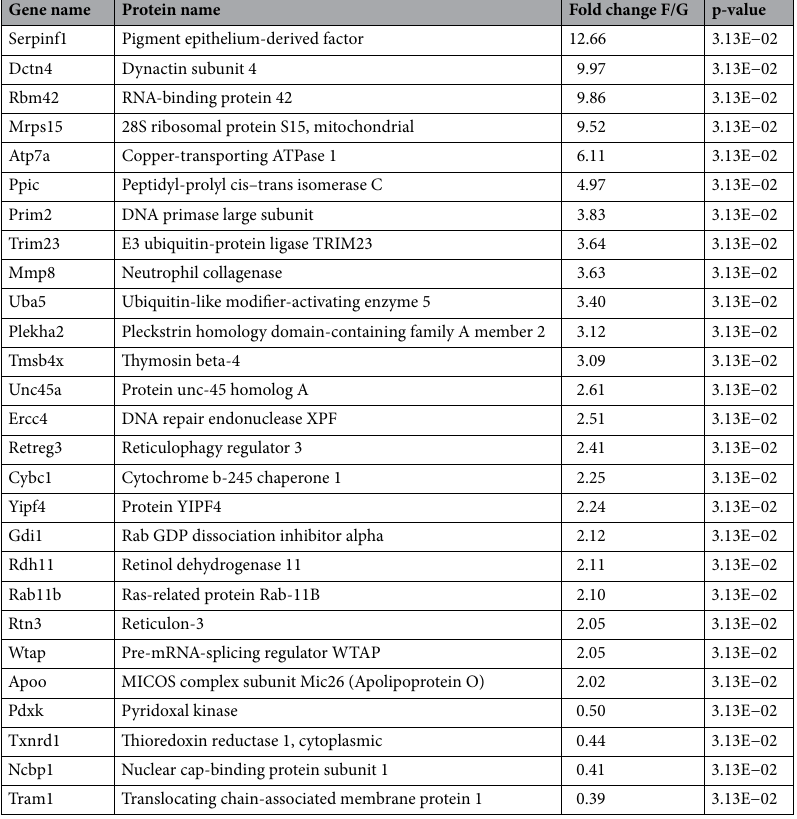
Table 2. Effect of collagen morphology on the protein expression profile of macrophages. 23 proteins were expressed at levels more than twofold higher in macrophages cultured on fibrous collagen type I-coated tissue culture plastic compared to macrophages in globular collagen-coated conditions, while four proteins were expressed at levels more than twofold lower (fold change < 0.5). N = 6, p < 0.05 was considered